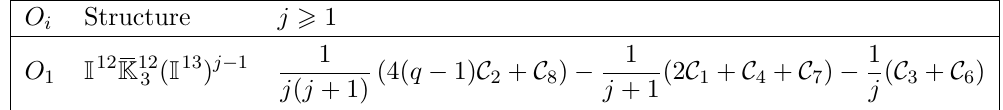
Table 16 . Expansion of the supersymmetric correlator in the component has spin (0 ; 1 ( j +1)) and QO has spin ( 1 2 to zero. C 6